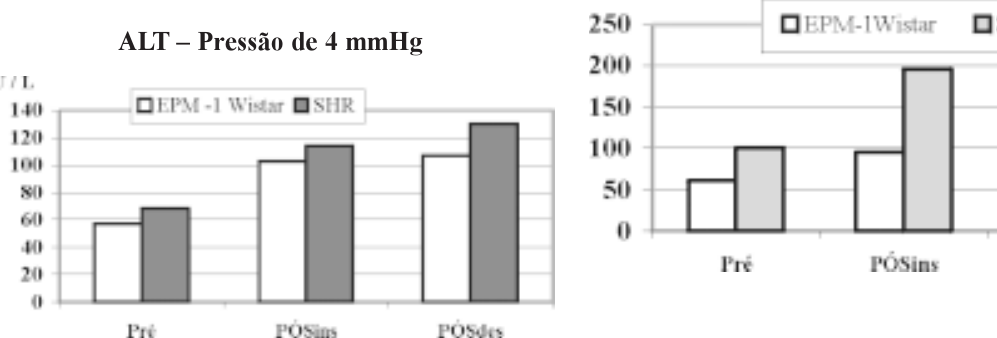
FIGURA 1 - N(cid:237)veis sang(cid:252)(cid:237)neos de AST, representados pelas medianas dos valores, para cada linhagem de rato, nos diferentes momentos de avalia(cid:231)ªo, com uma pressªo de 4mmHg de pneumoperit(cid:244)nio.